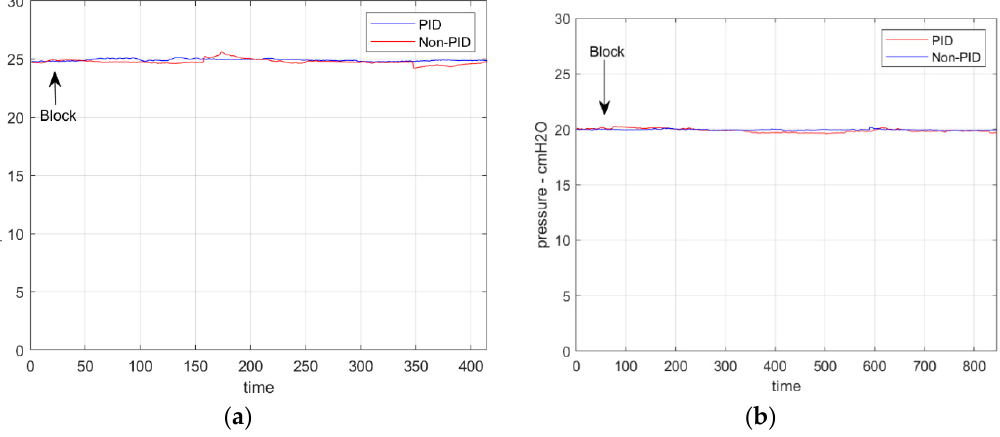
Figure 16. ( a ) PID pressure control at 25 cmH 2 O. For PID, mean is 24.90 and STD is 0.0954. For non-PID, mean is 24.76 and STD is 0.1648; ( b ) PID pressure control at 20 cmH 2 O. For PID, mean is 19.94 and STD is 0.054. For non-PID, mean is 19.86 and STD is 0.1632. PID control demonstrates the robustness for constant pressure regulation superior to the non-PID control.